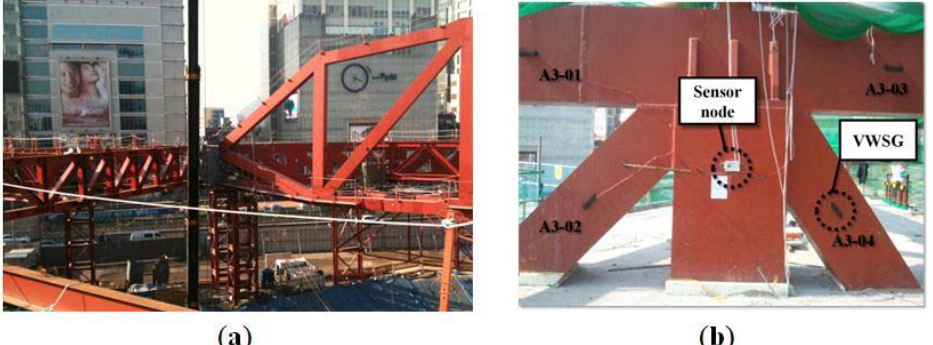
Figure 6. Application site during construction. ( a ) Mega-truss (A6 and A7 areas) during construction; ( b ) VWSG and sensor node of zone A3 in the